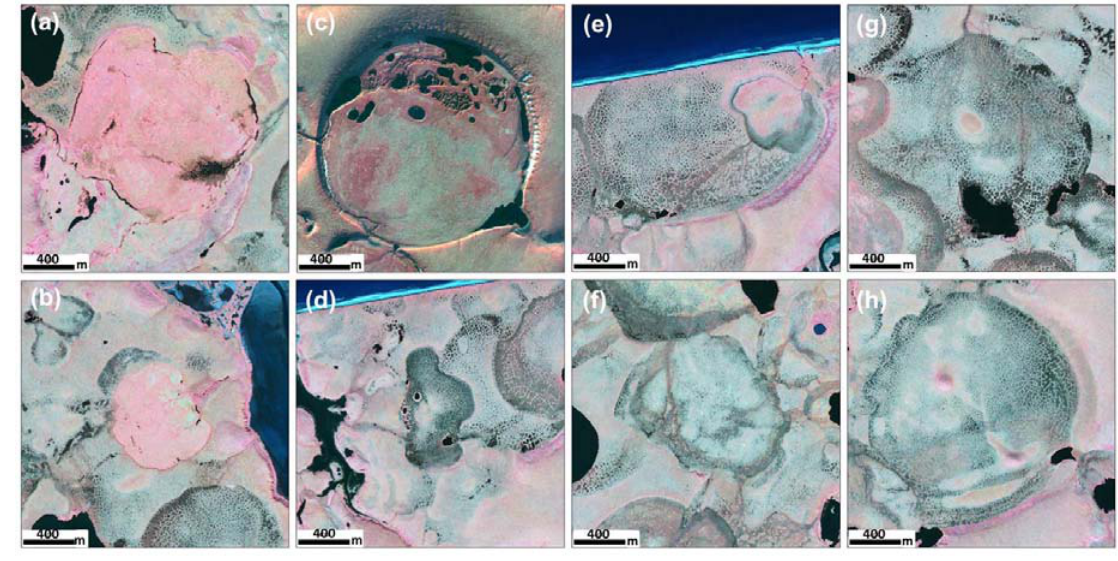
Figure 7. DTLB of different age classes located in the northern Seward Peninsula (Modern: ( a ) 9 yrs old, ( b ) 29 yrs old; Young: ( c ) 403 ± 55 cal·yr·BP, ( d ) 294 ± 15 cal·yr·BP; Medium: ( e ) 1471 ± 60 cal·yr·BP, ( f ) 770 ± 35 cal·yr·BP; Old: ( g ) 2719 ± 40 cal·yr·BP, ( h ) 2567 ± 80 cal·yr·BP; Modern basin ages from Grosse et al. [43] and radiocarbon dates from Jones et al. [10]). All images show bands 4-3-2 (near-infrared, red, green) and are in same scale. Image C is from Quickbird © DigitalGlobe; all others are from IKONOS © GeoEye. Vegetation appears in shades of pink with darker color representing high biomass. Water appears dark bluish or black, and bare or sparsely vegetated soil appears in shades of light blue or